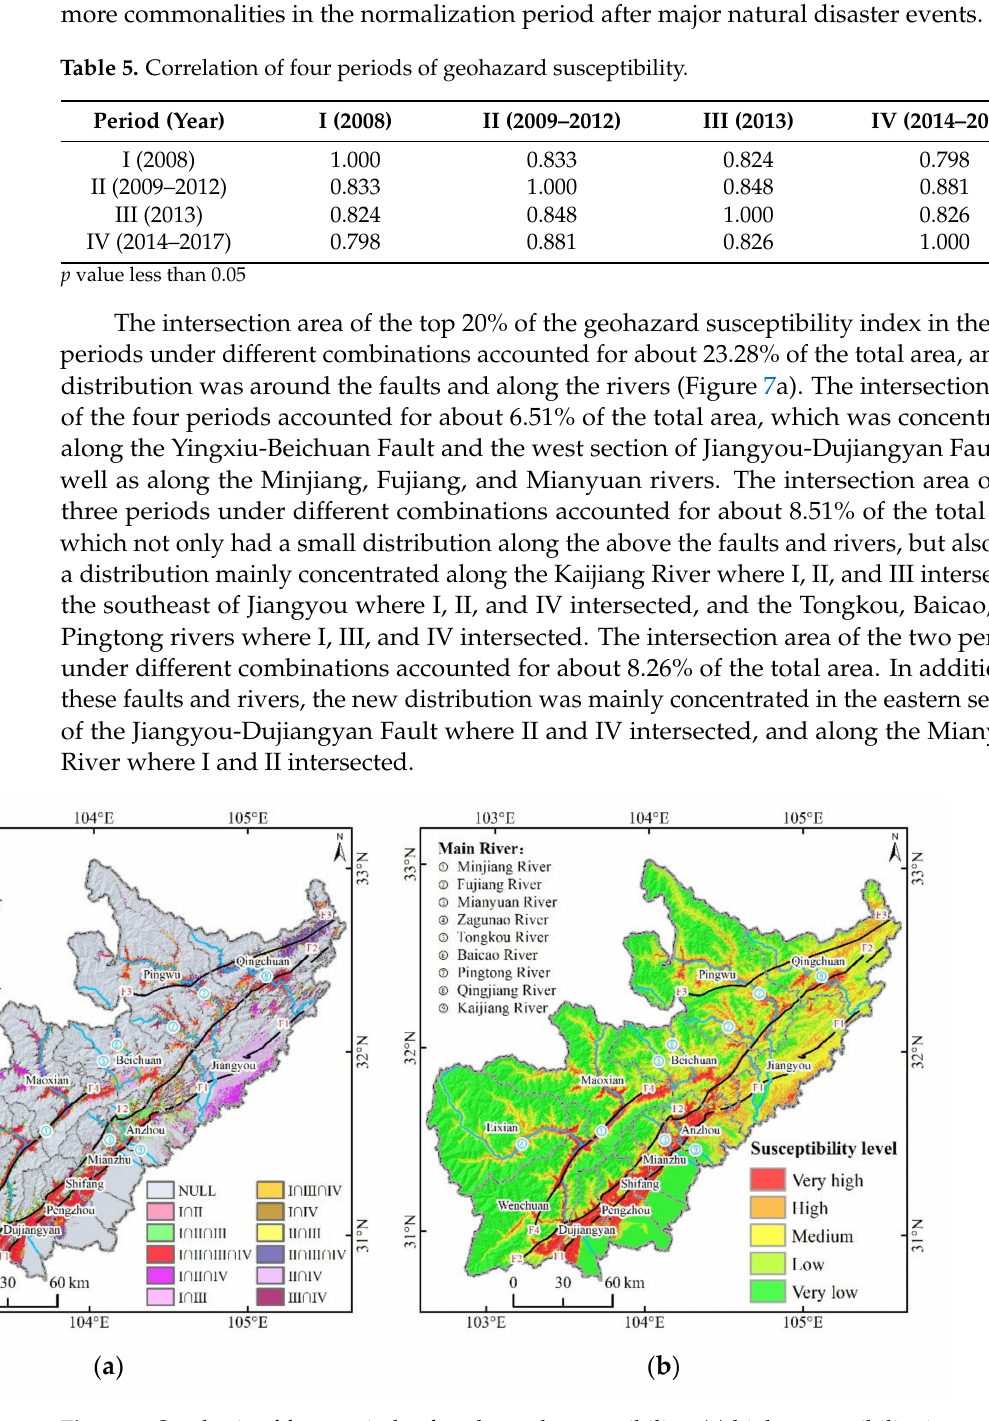
Figure 7. Synthesis of four periods of geohazard susceptibility: ( a ) high susceptibility intersection diagram in four periods (I is 2008; II is 2009–2012; III is 2013; IV is 2014–2017); and ( b ) geohazard susceptibility in